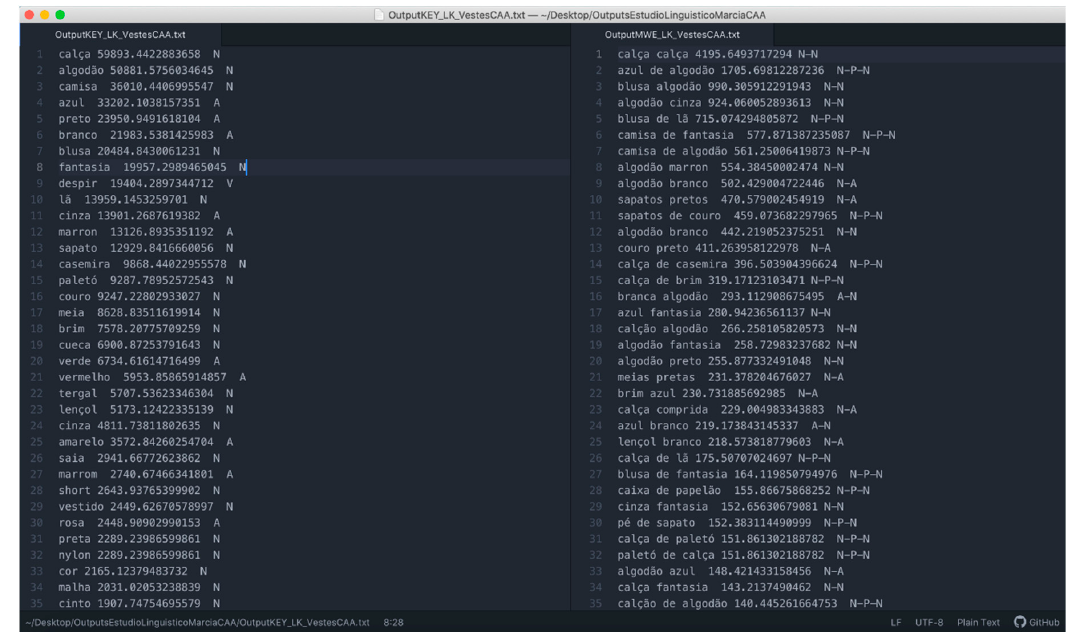
Figure 6. Linguakit output for keywords and multiword analysis of body description: Clothes and personal belongings ( Vestes ) in the ‘Disappearances in São Paulo’ corpus.